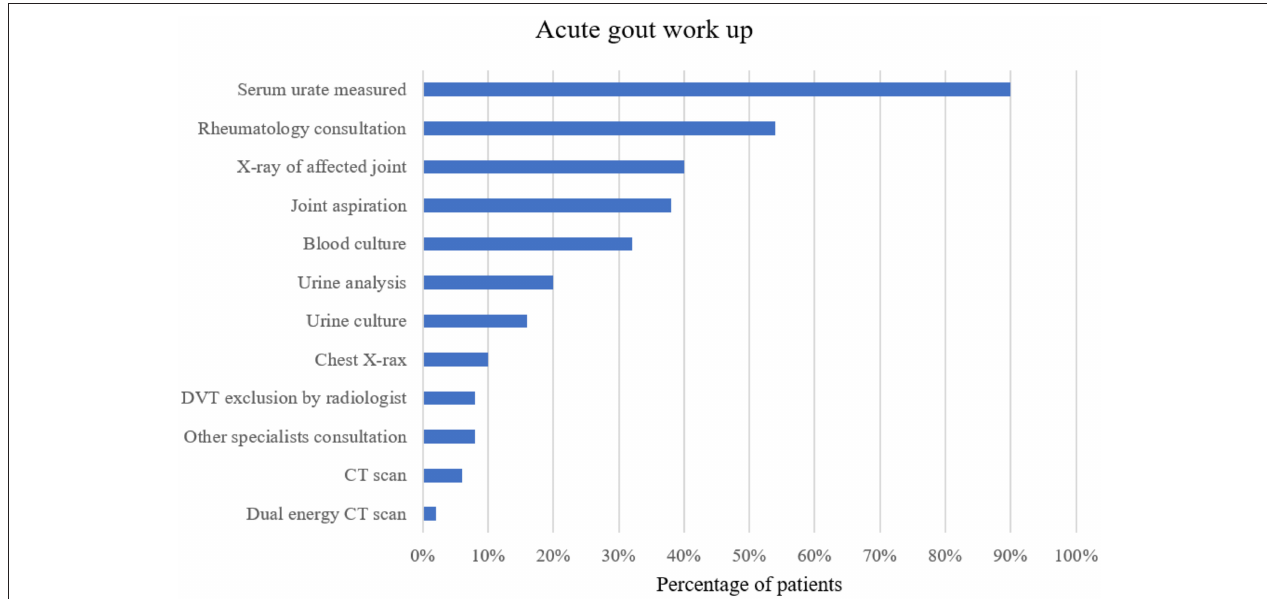
FIGURE 3 | Work-up for acute gout attack in percentage of patients with at least one of the investigations mentioned above. DVT, deep vein thrombosis; CT, computed tomography.